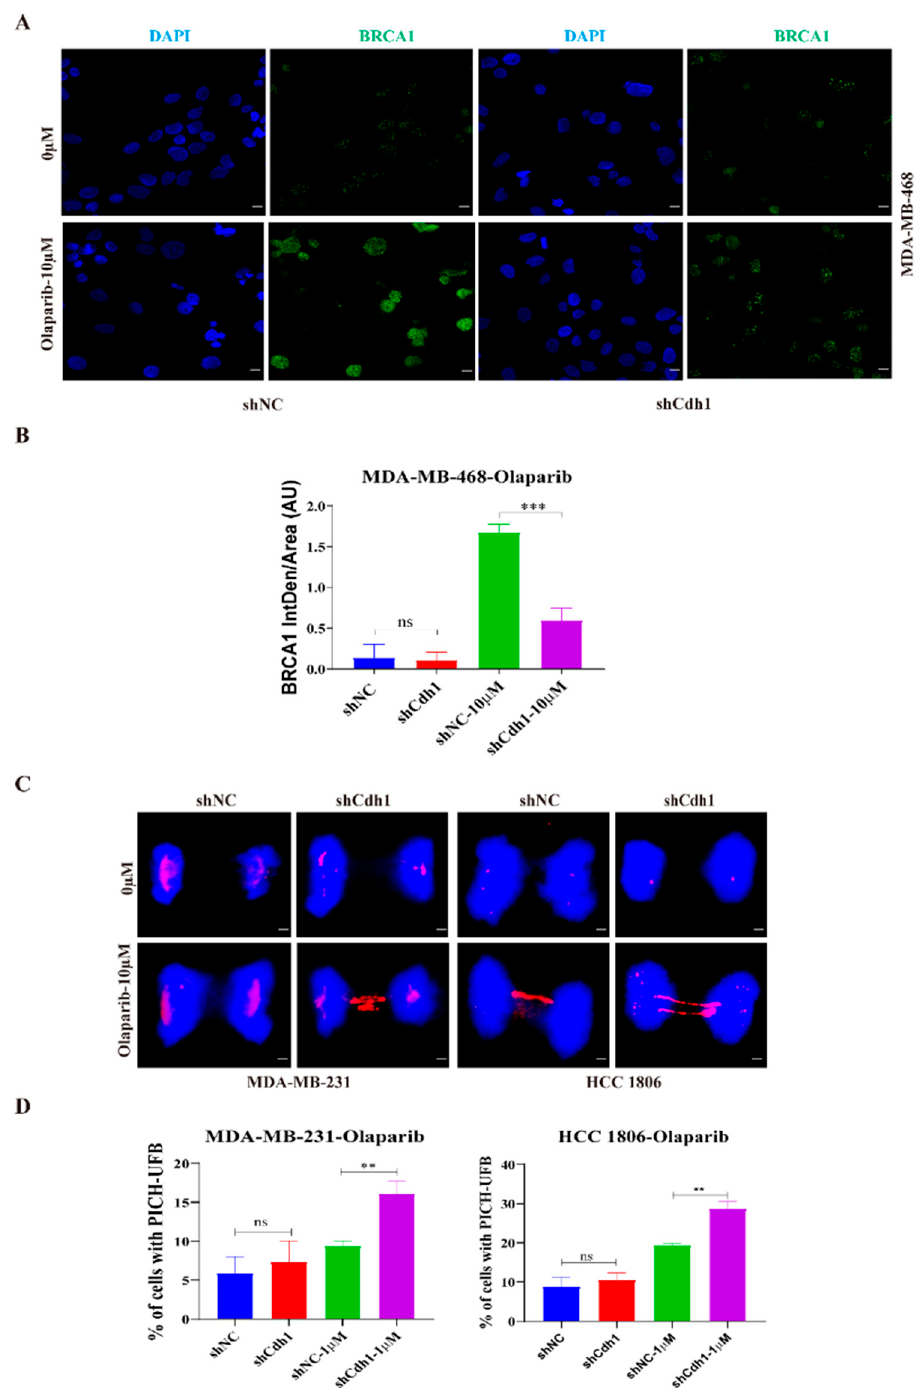
Figure 5. Cdh1 facilitates BRCA1 foci formation and prevents untangled DNA accumulation in mitosis following PARPi. ( A ) Immunofluorescence staining of BRCA1 in MDA-MB-468 cells transduced with scrambled shRNA (NC) or shRNA against Cdh1 in in response to olaparib (0 μ M and 10 µ M) for 96 h. Scale bar: 50 μ m; ( B ) the percentage of BRCA1 foci cells were quantified. Data are means of at least three independent experiments. Error bars indicate S.E.M. Significance of differences was calculated using Student’s t test (*** p < 0.001; ns: p ≥ 0.05.); ( C , D ) representative images ( C ) and quantification ( D ) of UFB at anaphase cells. PICH and DNA were visualized using anti-PICH antibody (red), and DAPI (blue), respectively. Scale bars, 10 μ m. Data are means of three independent experiments. Error bars indicate S.E.M. Significance of differences was calculated using Student’s t test ( ** p < 0.01; p ≥ 0.05.).